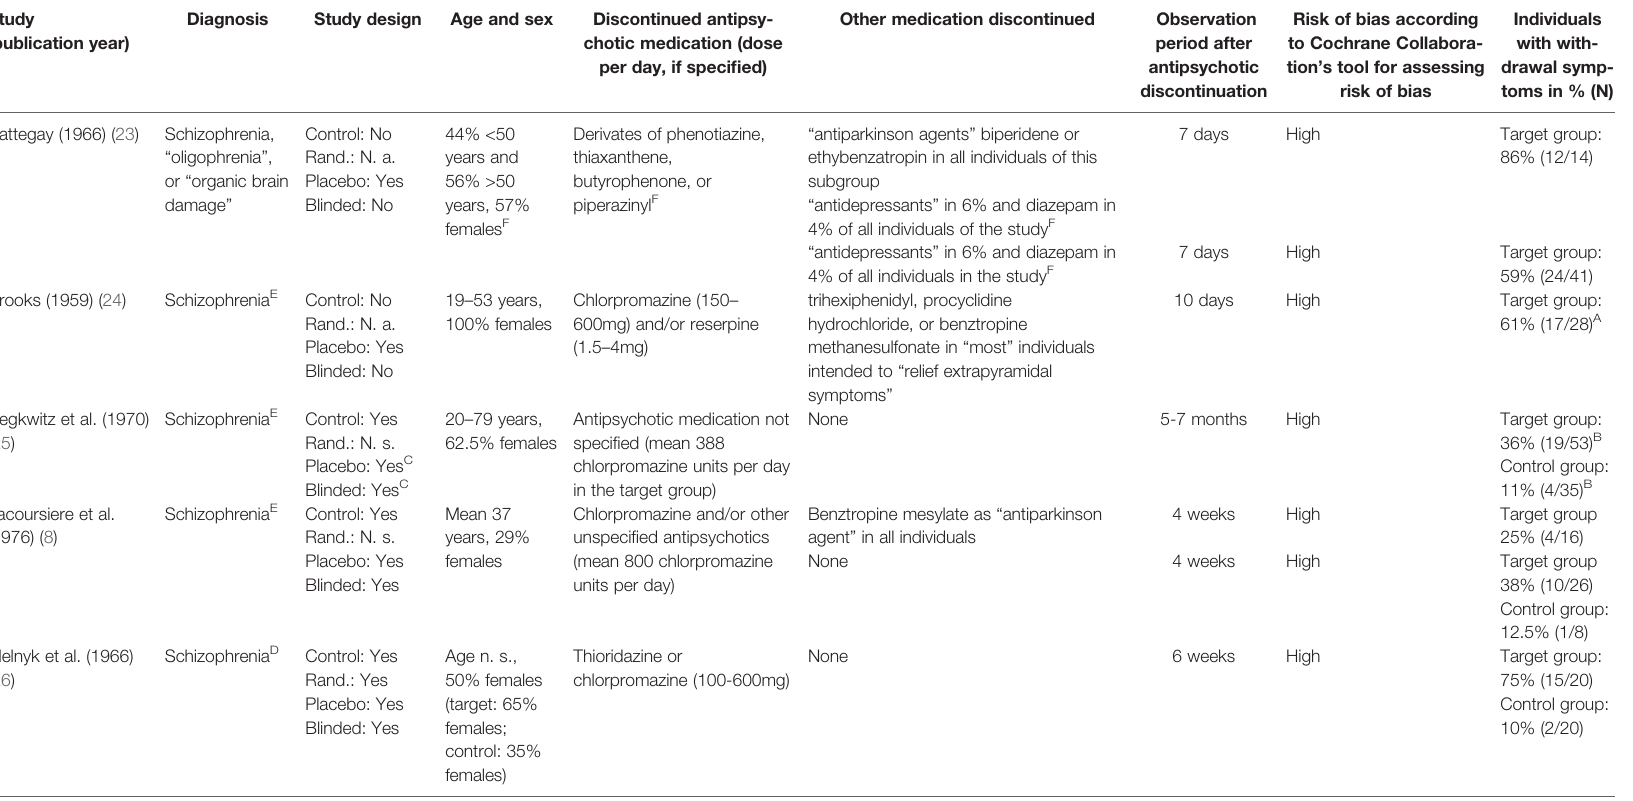
TABLE 1 | Included studies on the occurrence of withdrawal symptoms after abrupt antipsychotic discontinuation. Study (publication